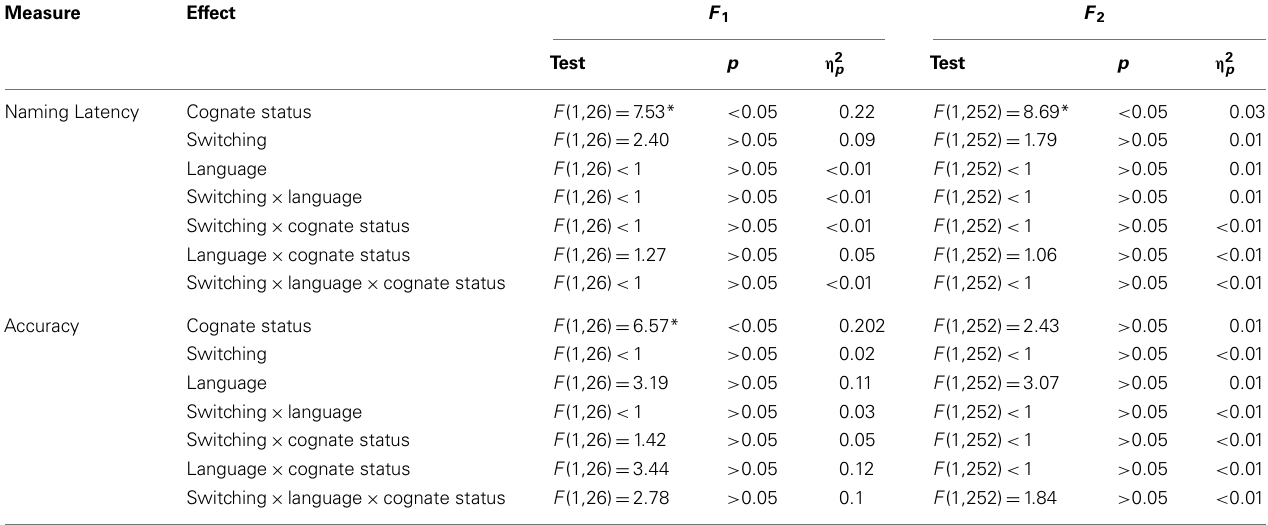
Table 3 | Mixed-languageANOVA